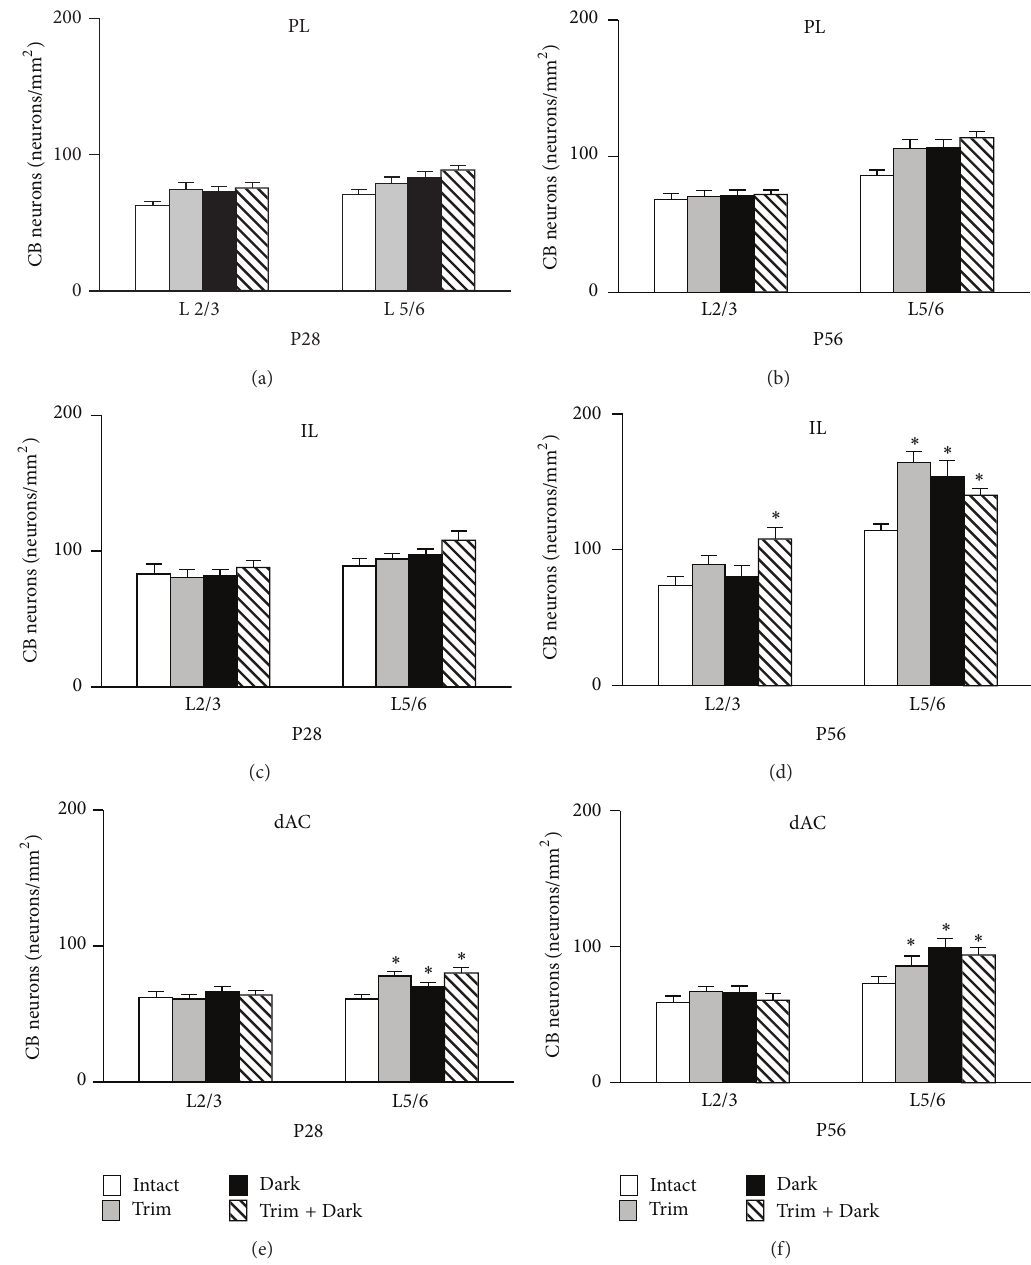
Figure 6: Sensory deprivation changes CB neuron density in the PFC. The density of CB neurons in the PL (a, b), IL (c, d), and dAC (e, f). CB neuron density at P28 (a, c, e) and P58 (b, d, f) in each area are shown. (a)-(b) The density of CB neurons was not affected in sensory deprived mice in the PL. (c)-(d) At P56 the density of CB neurons in L5/6 was increased by sensory deprivation. (e)-(f) The density of CB neurons in L5/6 was increased with sensory deprivation at P28 and P56. Data are expressed as mean density S.E.M. ( 𝑛 = 6 per group). Abbreviations are the same as in Figure 4. ∗ 𝑃 < 0.05 compared with intact